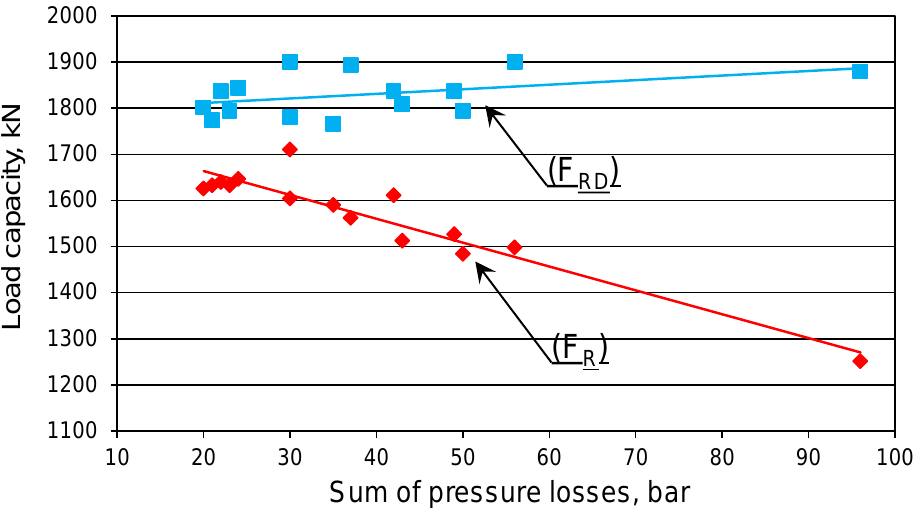
Figure 12. Analysis of the prop ’ s actual load capacity before charging F R (a) and after charging F RD (b).